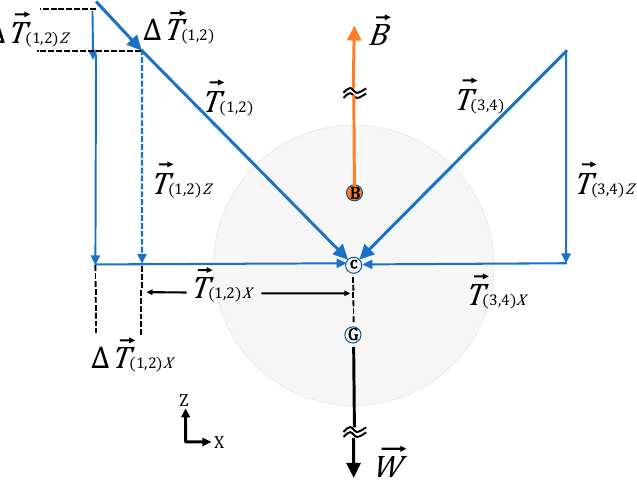
Figure A1. Case 1: Unbalanced thrust increase.